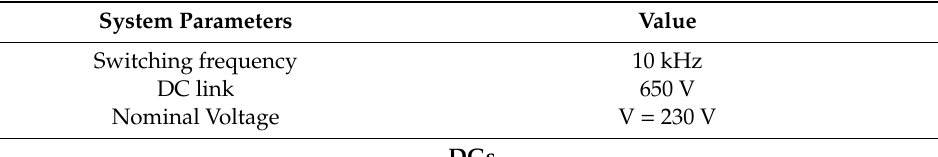
Table 1. System parameters.